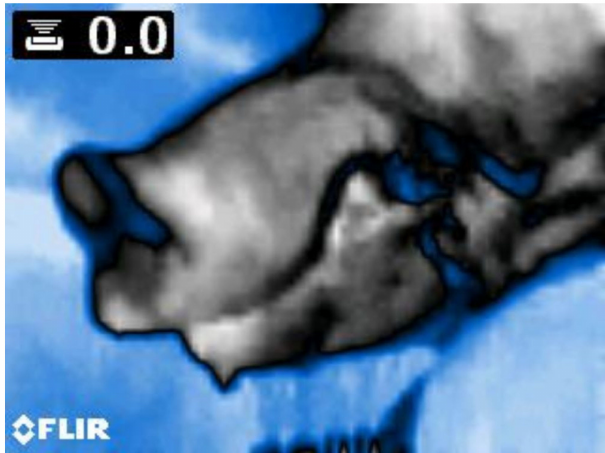
Figure 2. Boar salivation and face moisture imaging during